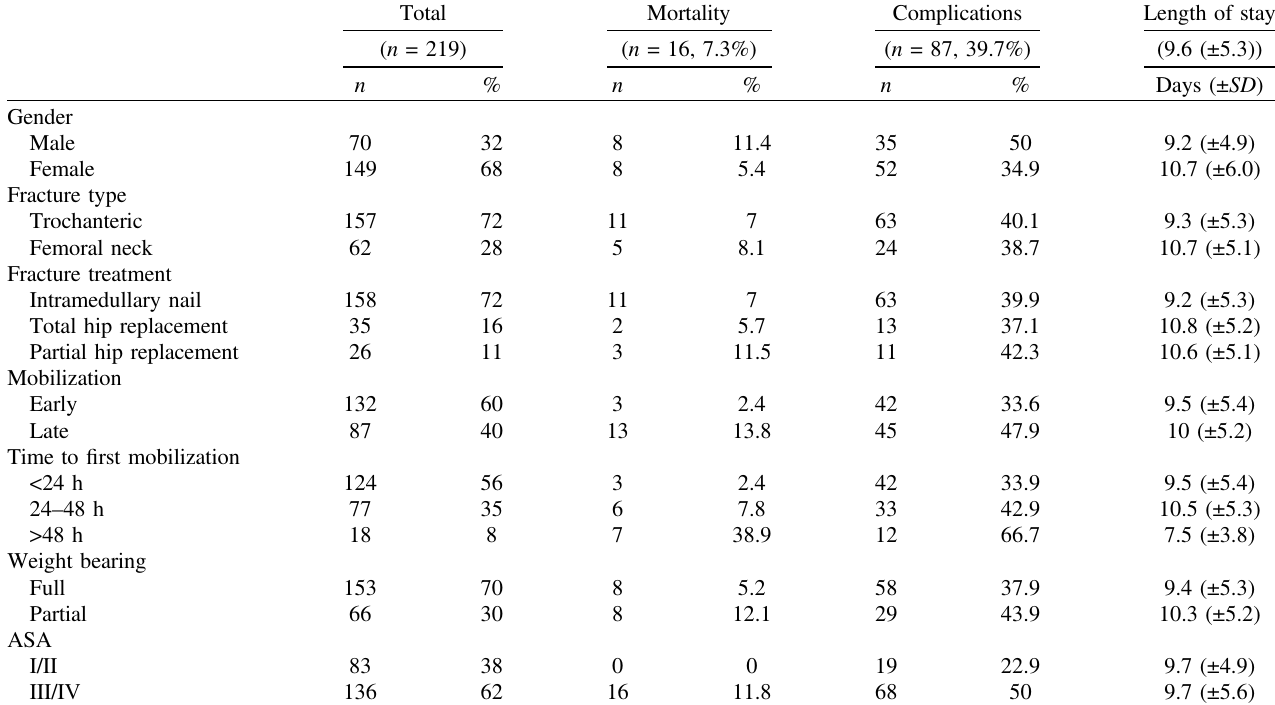
Table 1. Overview.